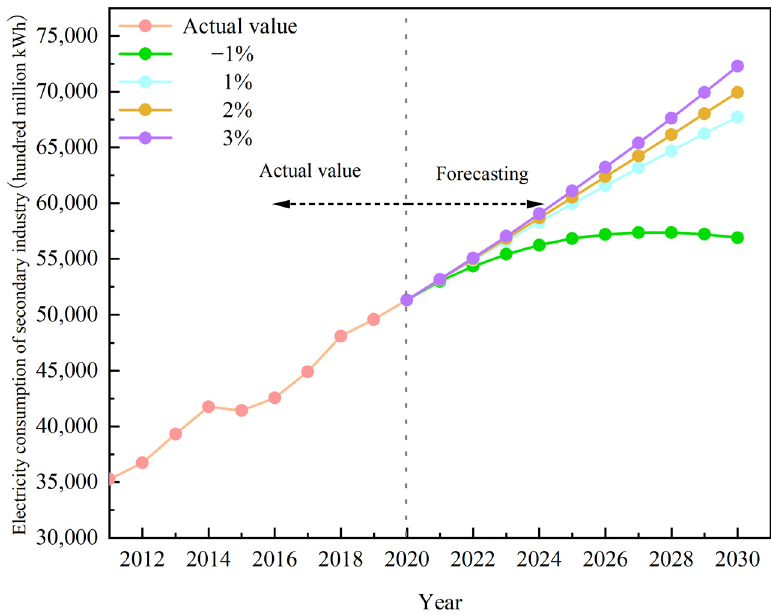
Figure 5. Forecasted results of power consumption of China’s secondary